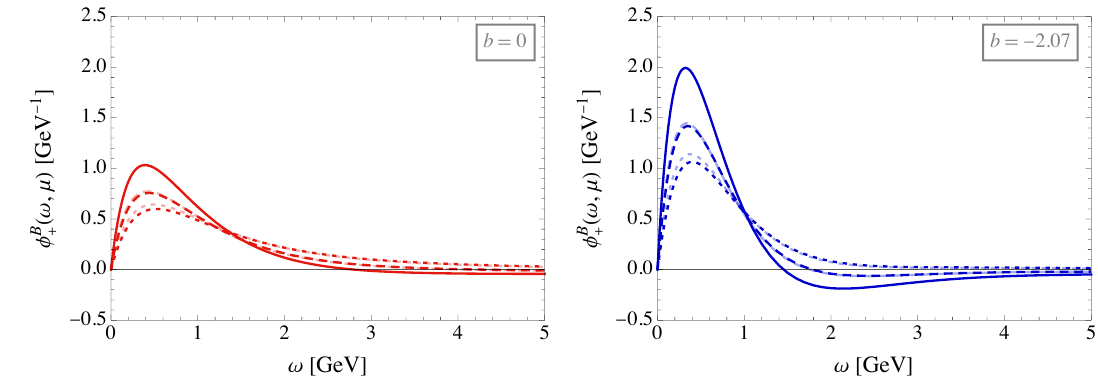
Figure 6 . Scale evolution of the model functions for the LCDA in momentum space with ω 0 = 482 MeV and b = 0 (left), b = − 2 . 07 (right). The solid lines show the results at µ = µ s = 1 GeV, the dashed lines correspond to µ = 1 . 5 GeV, and the dotted lines refer to the scale of the b -quark pole mass, µ = m b = 4 . 8